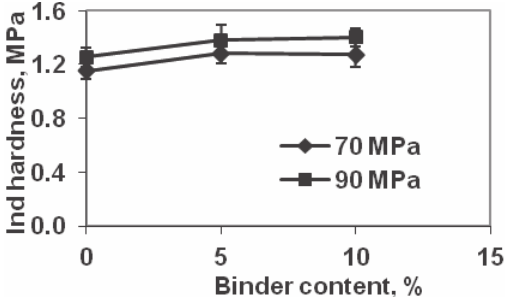
Fig. 4 Indentation hardness of tablets.